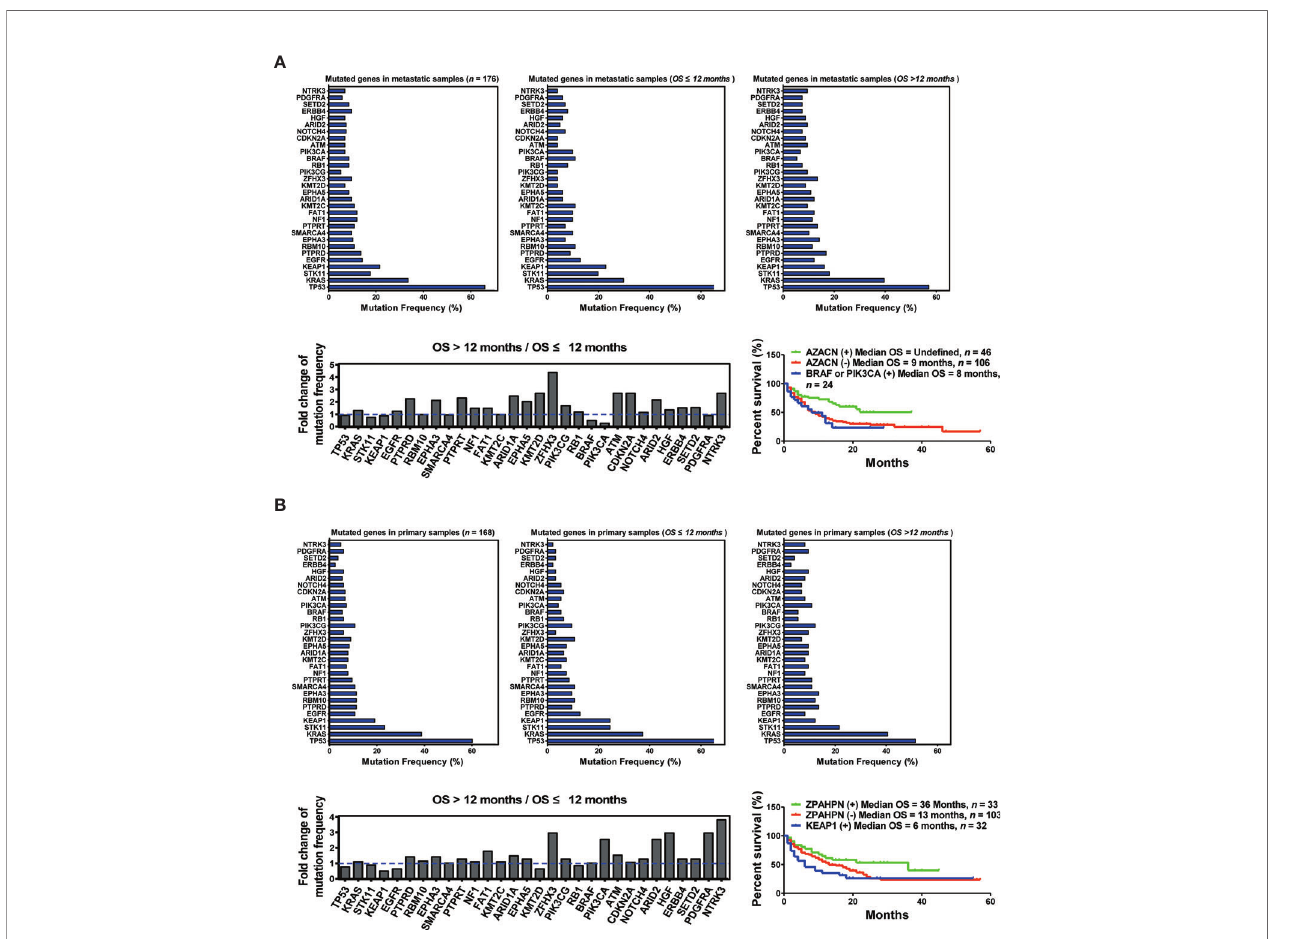
FIGURE 3 | Biopsy lesion type affects the stratifying factors of immunotherapy. (A) Up left: Mutation frequency of the top 30 genes in the metastatic sample cohort. Upper middle: Mutation frequency of the top 30 genes in the metastatic sample cohort with OS ≤ 12 months. Upper right: Mutation frequency of the top 30 genes in the metastatic sample cohort with OS >12 months. Down left: Fold change in mutation frequency with OS >12 months/OS ≤ 12 months for the top 30 genes. Down right: Kaplan – Meier curve analysis of OS strati fi cation using the AZACN ( ARID1A , ZFHX3 , ATM , CDKN2A , and NTRK3 ) mutation status. (B) Upper left: Mutation frequency of the top 30 genes in the primary sample cohort. Upper middle: Mutation frequency of the top 30 genes in the primary sample cohort with OS ≤ 12 months. Upper right: Mutation frequency of the top 30 genes in the primary sample cohort with OS >12 months. Down left: Fold change in mutation frequency with OS >12 months/OS ≤ 12 months for the top 30 genes. Down right: Kaplan – Meier curve analysis of OS strati fi cation using the ZPAHPN ( ZFHX3 , PIK3CA , ARID2 , HGF , PDGFRA , and NTRK3 ) mutation